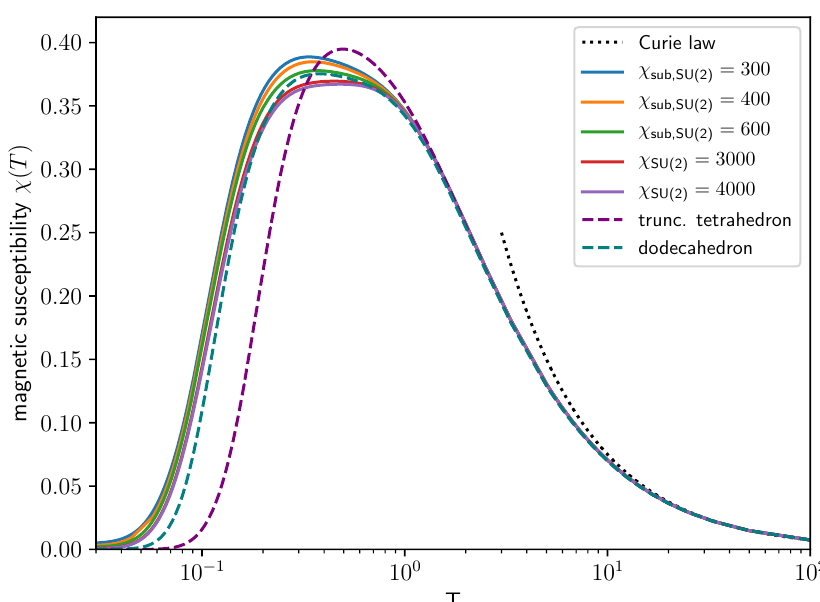
Figure 9: Zero-field uniform magnetic susceptibility C dimensions. Parameters as in Fig.